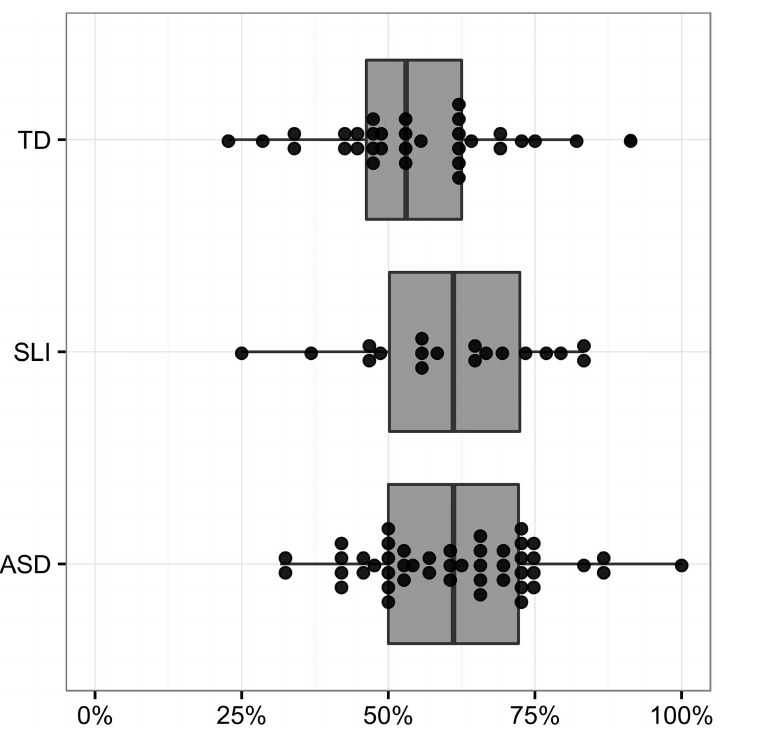
Fig 2. Percent of content mazeswhich are repetitions (versusrevisions).